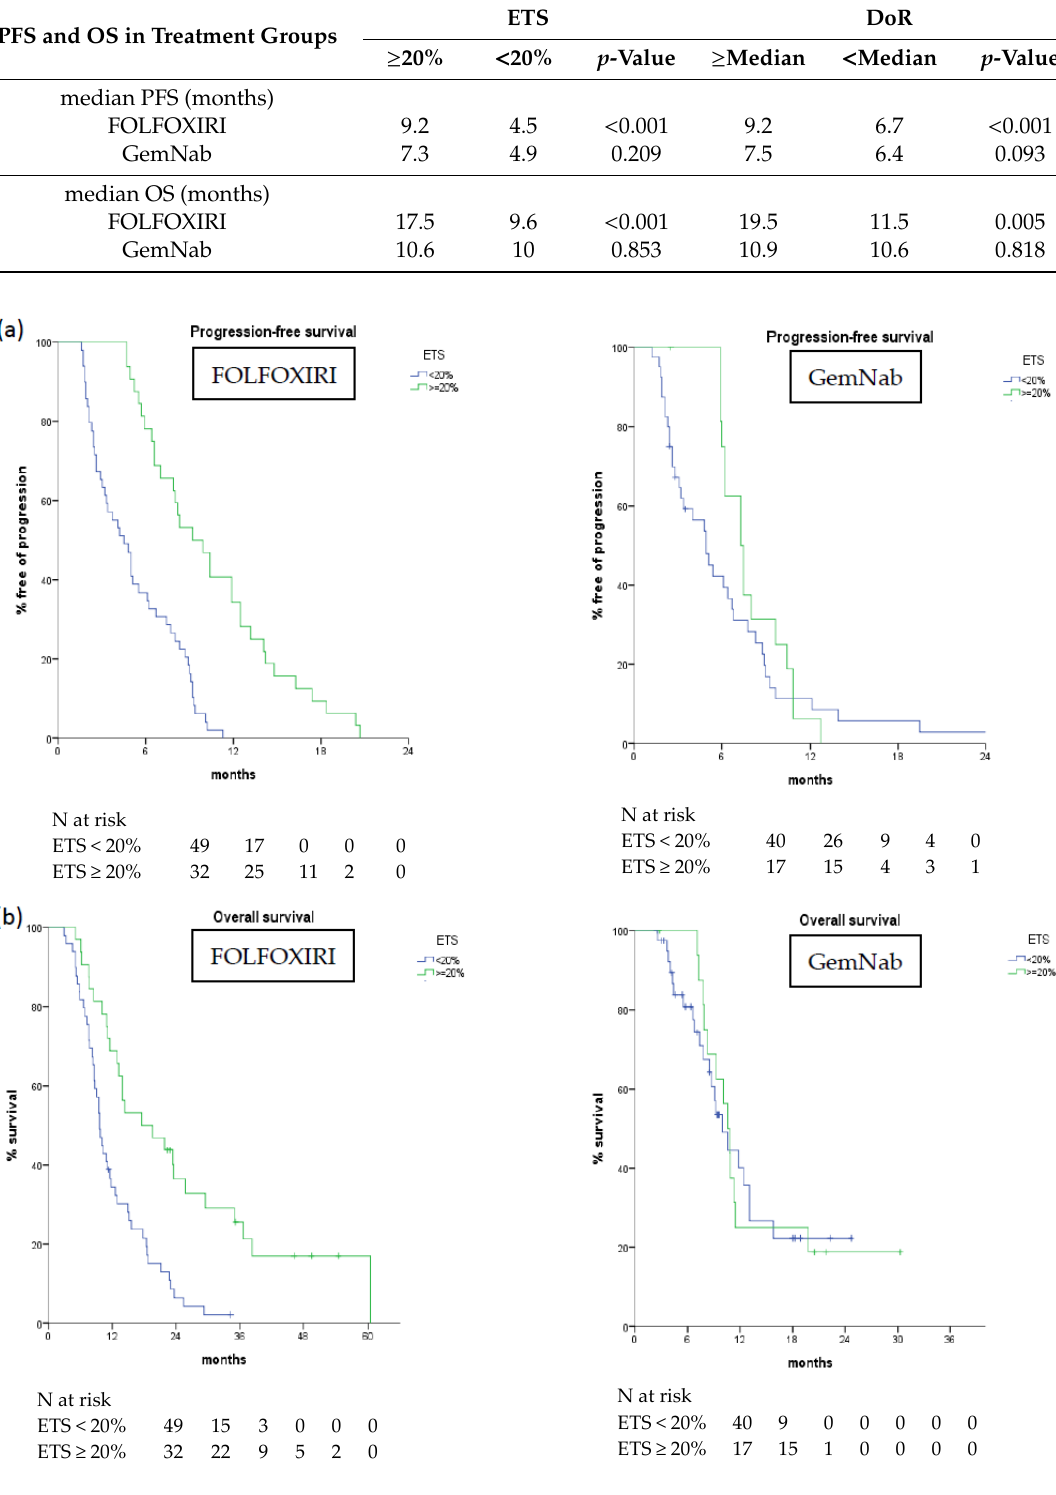
Figure 2. Progression-free survival ( a ) and overall survival ( b ) according to ETS in FOLFOXIRI and GemNab group.